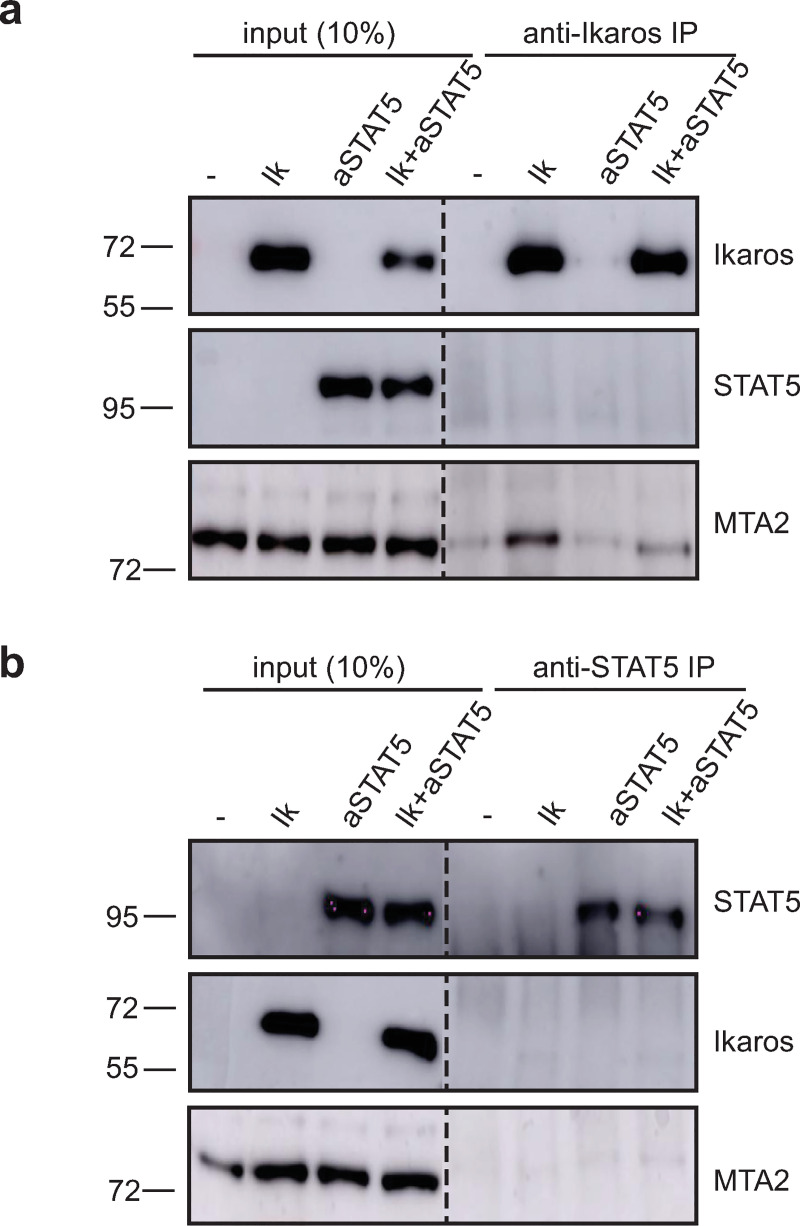
Ikaros and STAT5 do not associate.Western blot analysis for the indicated proteins after immunoprecipitation with anti-Ikaros (a) and anti-STAT5 (b) antibodies. 10% input of nuclear extracts of COS cells transfected with empty vector (-), or expression vectors for Ikaros-1 (Ik) and a constitutive active form of STAT5a (aSTAT5) are shown. The dashed lines indicate two parts of the same membrane. The original and uncropped Western blot images are provided in S1 Raw images.